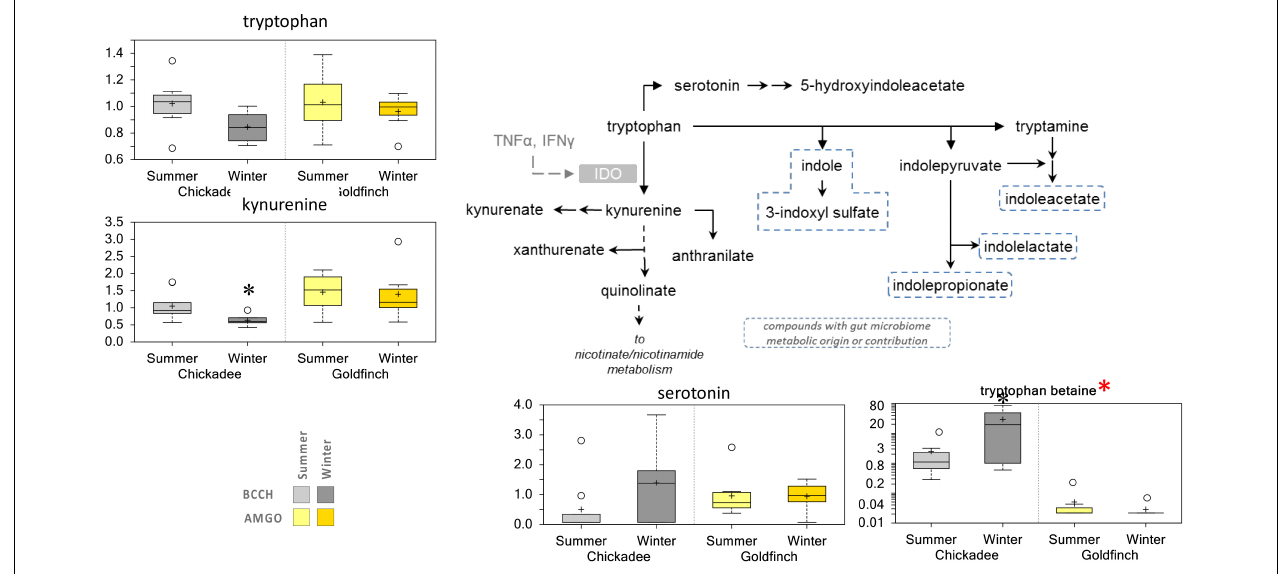
FIGURE 7 | Differences in the abundances of metabolites involved tryptophan metabolism in pectoralis muscle of Black-Capped Chickadee (BCCH) and American Goldfinch (AMGO). The X -axis represents the species and the seasons sampled. The Y -axis box plots indicate the scaled intensity mean (+) and median (-) values: upper and lower ranges of boxes indicate upper and lower quartiles, respectively; upper and lower whiskers indicate the maximum and minimum distributions of the data; small circles represent outlying data points. Red asterisk—The Y -axis of this plot has been transformed to a log-scale to better show population differences. ∗ Significantly ( p < 0.05 and q < 0.10) different compared to the other season within the